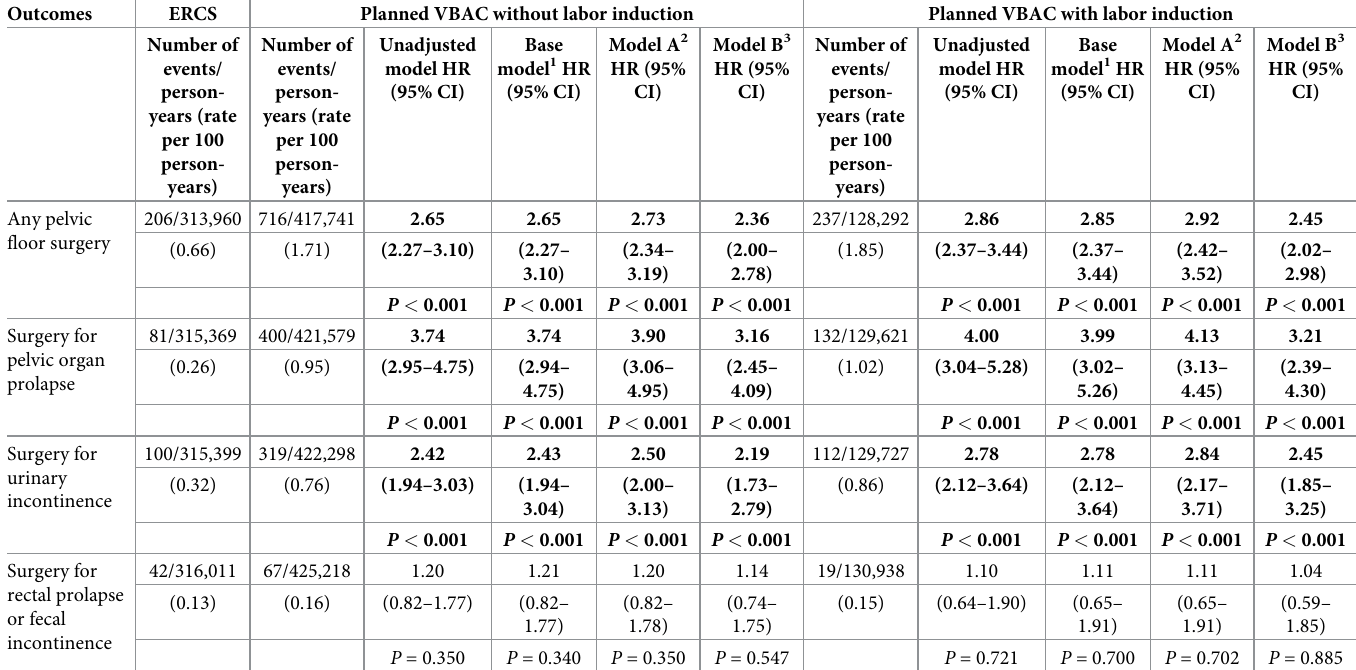
Table 3. Outcomes following planned VBAC with and without labor induction compared to